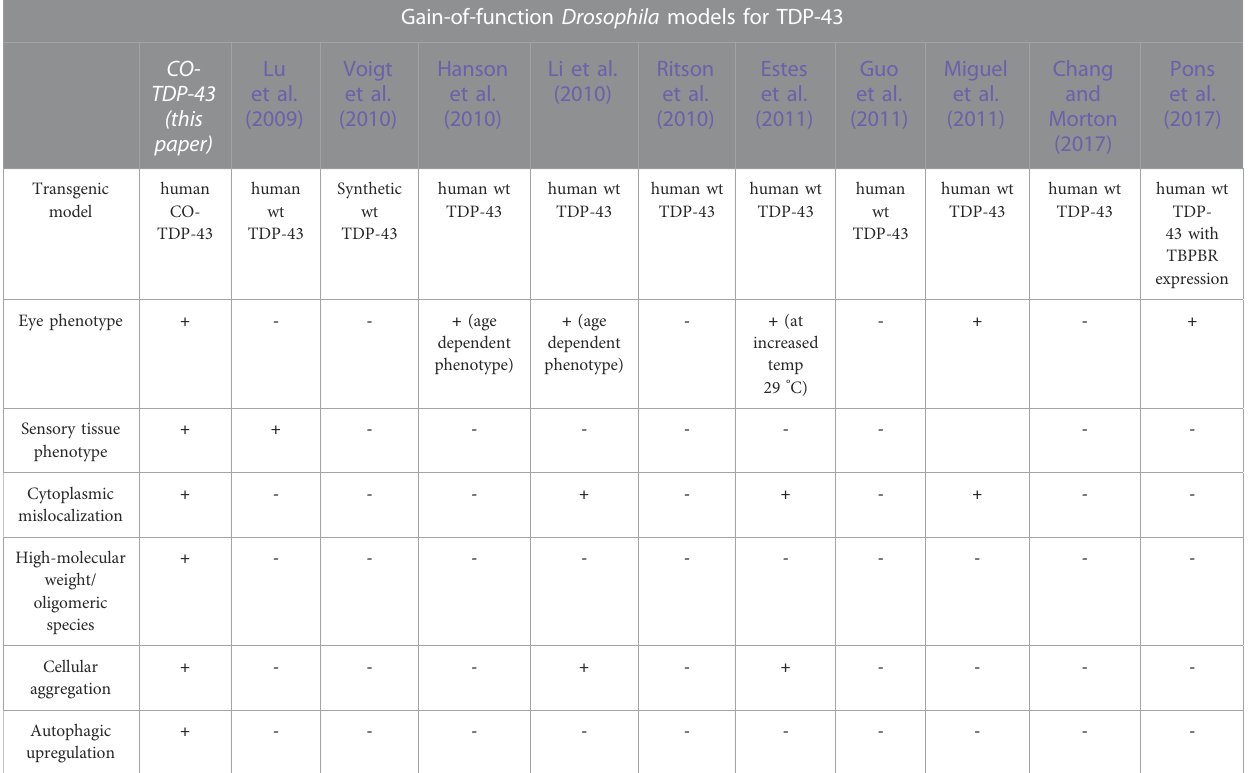
TABLE1Gain-of-functionDrosophilamodelsforTDP-43.Acomparison ofhumanwild-typeTDP-43transgenicgain-of-functionmodelsandcodon-optimized TDP- 43 models for disease-speci fi c fi ndings. Gain-of-function Drosophila models for